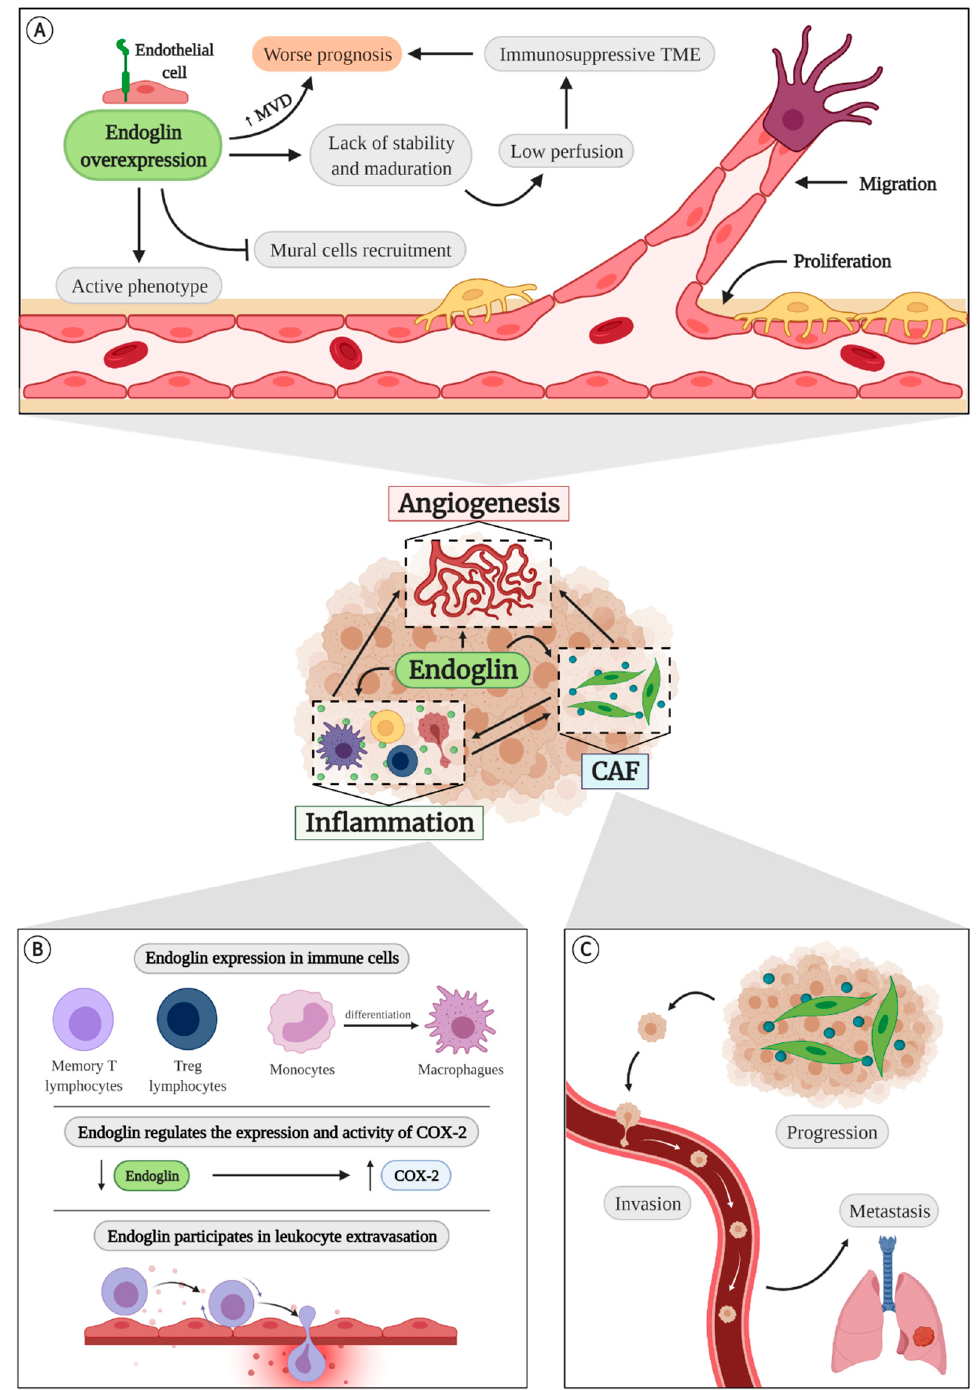
Figure 4. Endoglin plays an important role in the three factors involved in the generation of an immunosuppressive TME: angiogenesis, inflammation, and CAFs. ( A ) Endoglin in angiogenesis . Endoglin overexpression maintains an active phenotype in ECs and prevents recruitment of mural cells, which leads to impaired maturation and stabilization of the vessels. This results in low perfusion that could lead to an immunosuppressive microenvironment, which would be responsible for the worse prognosis associated with tumors with high endoglin levels. In fact, endoglin immunohistochemistry is used to measure microvascular density and determinate the tumor prognosis. ( B ) Endoglin and inflammation . Endoglin is expressed in different types of immune cells. Moreover, endoglin regulates the expression and activity of COX-2 and participates in leukocyte extravasation. ( C ) CAFs and endoglin. Increased endoglin expression in CAFs promotes invasion and metastases. Created with BioRender.com.